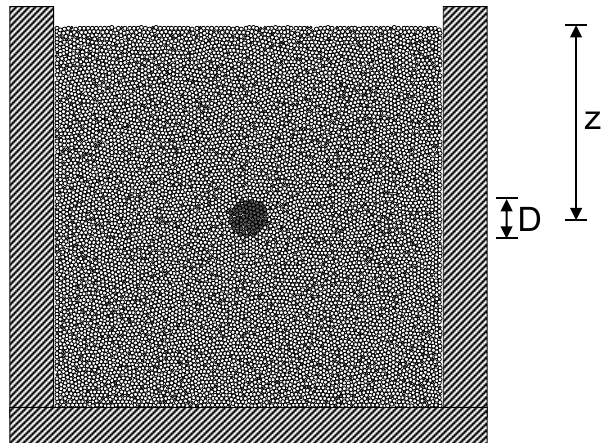
Figure 1. Initial model showing inclusion depth z and size D. Dark-colored grains are soluble. (This case corresponds to z/D = 5).